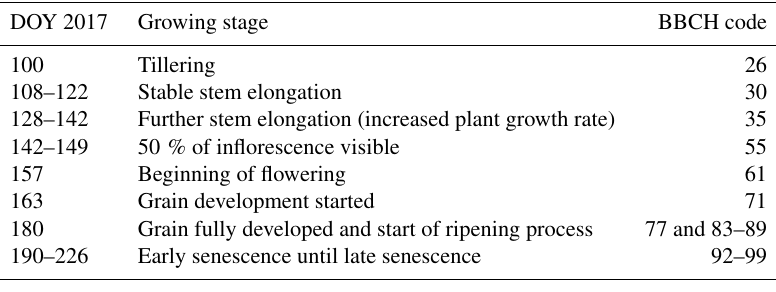
Table 1. Overview of growth stages of the winter wheat between 10 April (DOY 100) and 14 August 2017 (DOY 226) and their corresponding